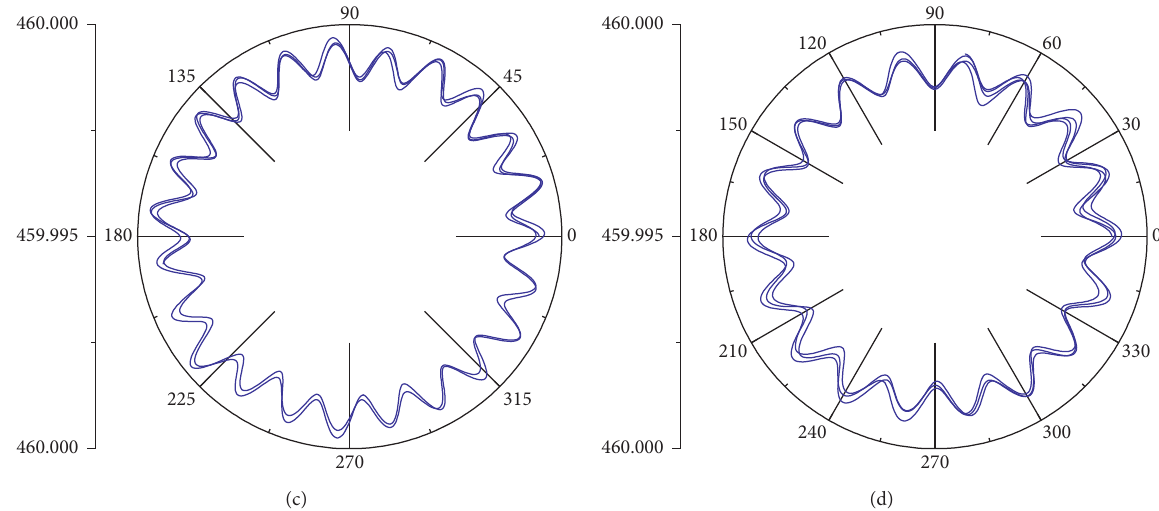
Figure 7: Wheel wear shape at different speeds. (a) v � 240km/h, N � 25.22. (b) v � 260km/h, N � 23.2. (c) v � 262km/h, N � 23. (d) v � 335km/h, N � 18. Frequency = 581.6 Hz